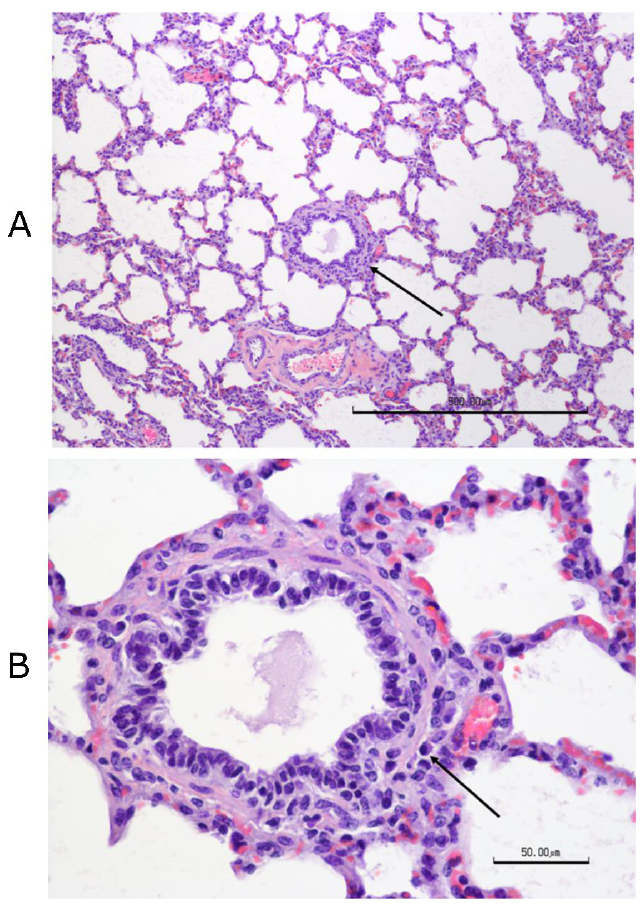
Figure 14. ( A ) QMV–BVD2* vaccine group: Minimal bronchiolar change with few peribronchiolar lymphocytes and plasma cells (arrow). Alveolar spaces are clear, and septa are normal. Bar = 500 µM. ( B ) QMV–BVD2* vaccine group: Limited plasma cells (arrow) and lymphocytes are present in the peribronchiolar interstitium in approximately normal numbers. The smooth muscle may be mildly hypertrophied, but it also may be an artifact of perimortem contraction. Bar = 50 µmM. The statistical analysis of histological lesion scores recorded in Table S8 indicated that there were significant differences in the efficacy levels across the three groups ( p < 0.049, 𝜂 𝑝2 = 0.42). Specifically, a significant difference was detected between the QMV–BVD2* and control groups in Bronchi ( p < 0.05). In other words, QMV–BVD2*(M = 1, SD = 0.67) protected the calves significantly better for lung lesions after the BVDV–2 challenge when compared with the calves in the control group (M = 1.76, SD = 1.12) (Figure 15; Table S8).